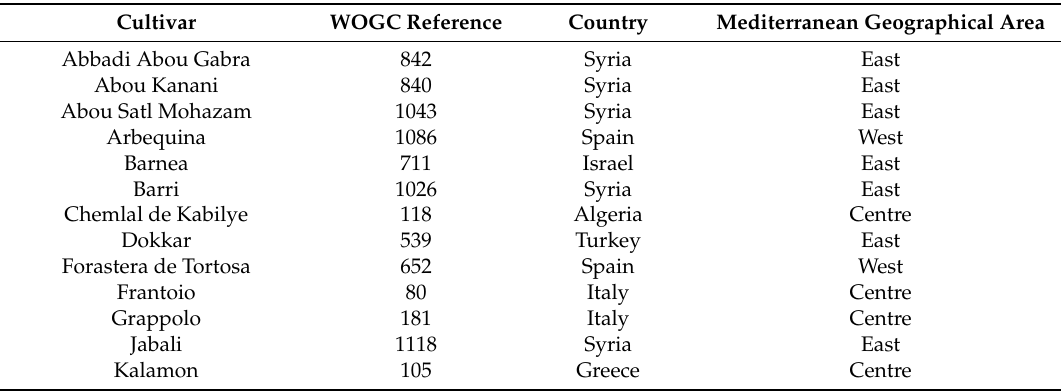
Table 1. Olive cultivars included in the Core-36